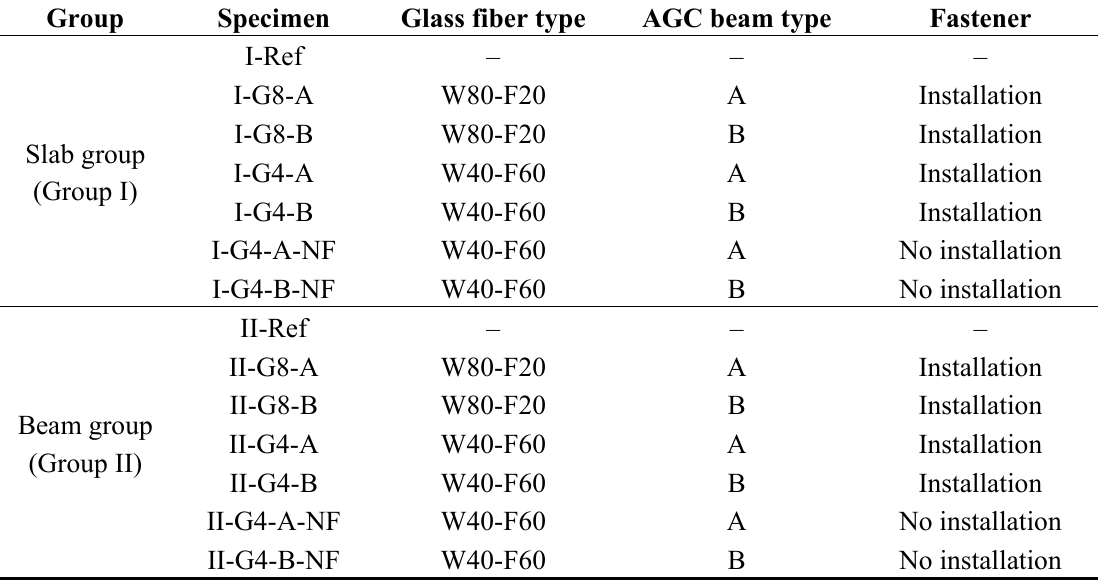
Table 2. Matrix of